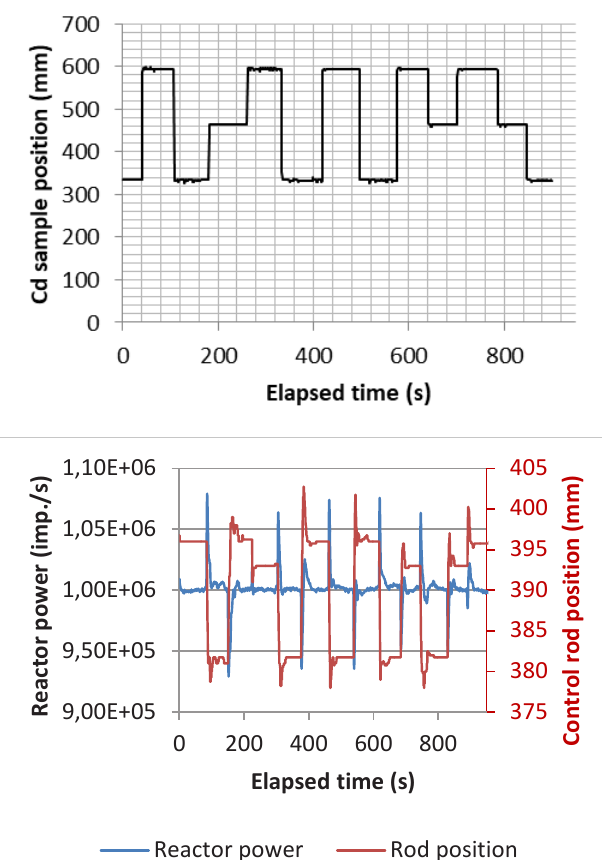
Fig. 5. Example of a disturbance rejection test. The operator was asked to keep the power at a constant level. The device for dynamics studies provided external reactivity changes which were to be compensated by an operator using control rod movements. Up: Movement of Cadmium (Cd) sample in device for dynamics studies; Down: operator response by control rod movement and reactor power evolution. The rods can be moved from 0 to 680 mm, and the active part of fuel assemblies is 600